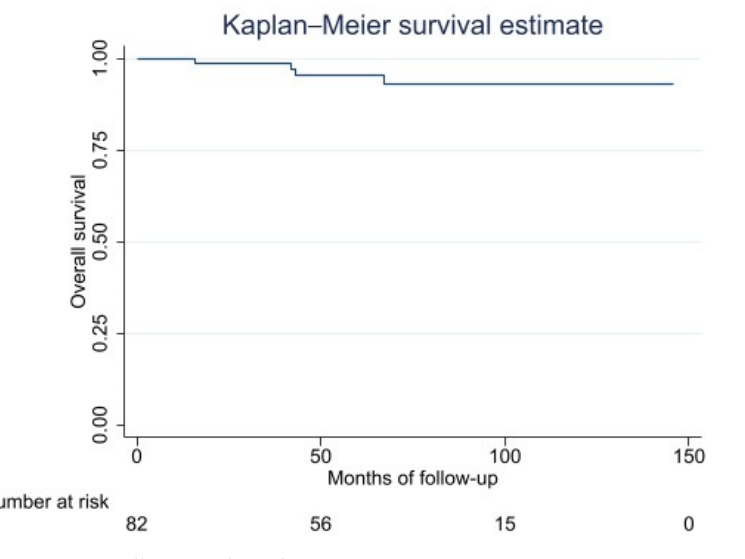
Figure 1. Overall survival Kaplan–Meier curve. Table 2. Kaplan–Maier Overall Survival (OS) estimates from patient characteristics.